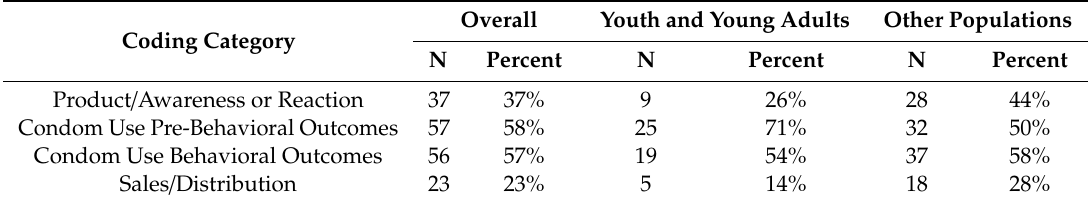
Table 5. Significant e ff ects